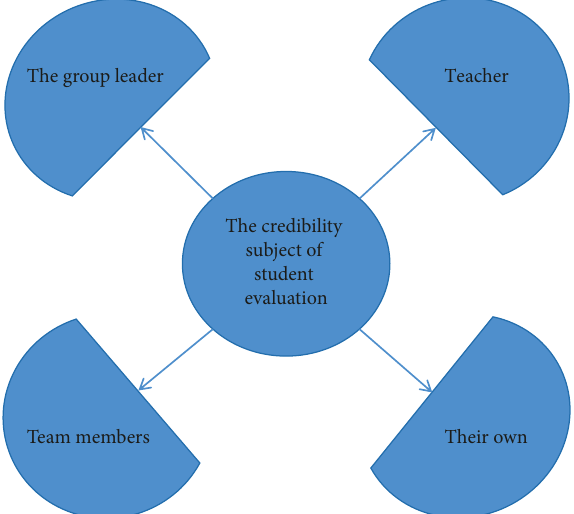
Figure 8: Student evaluation credibility subject.